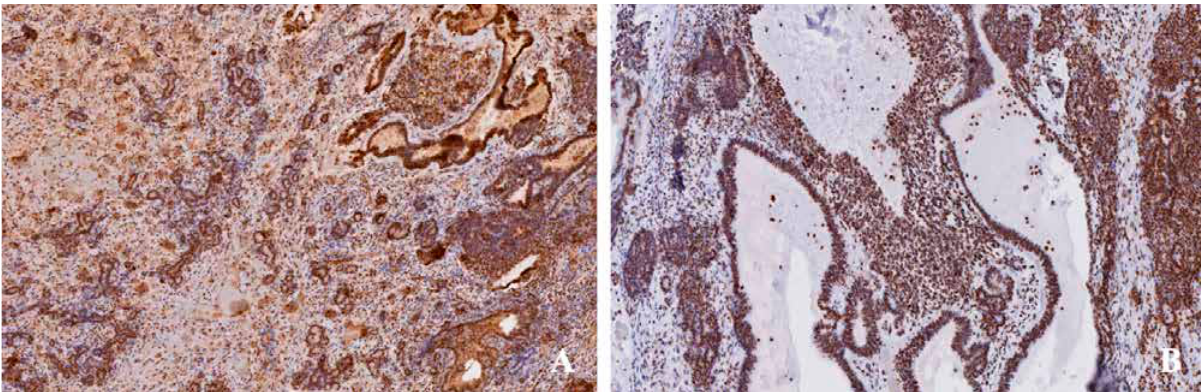
Figure 3: Immunophenotypes of the mixed germ cell tumor. A) Immunohistochenmical images showing that tumor cells were all positive after staining with monoclonal anti-AFP antibody (magnification: ×100). B) A representative image showing that OCT3/4 was positive in components of embryonal carcinoma